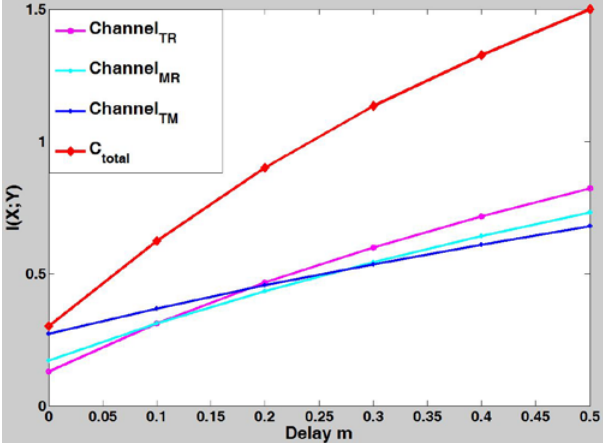
Figure 3: Upper bounds of the capacity of the molecular relay channel for smaller values of the delay constraint. The drift velocity has been set to v = 2, 1, 1.5 for C TR , C TM , C MR, and the channel parameter λ is assumed to be